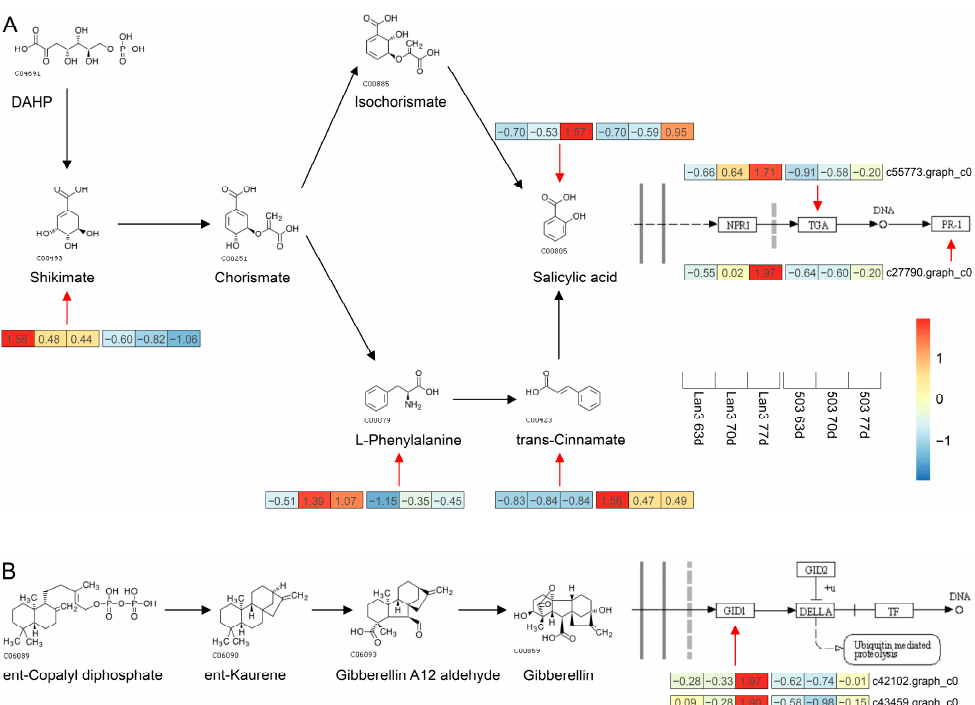
Figure 8. Biosynthesis and signal transduction of salicylic acid ( A ) and gibberellin ( B ) in V. sativa . Heatmap of transcript levels for genes and contents of the metabolites involved in the biosynthesis and signal transduction of salicylic acid and gibberellin.